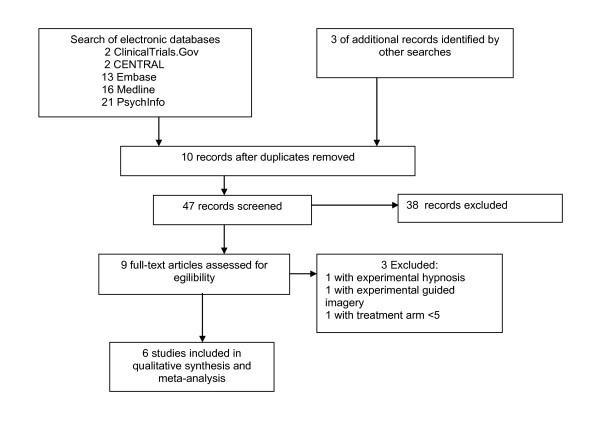
PRISMA flow diagram.